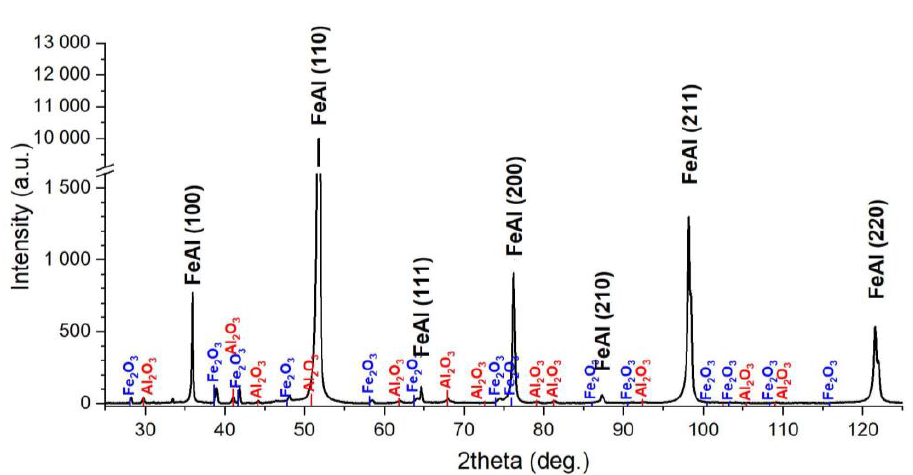
Figure 3. XRD analysis of the Fe40Al specimen.